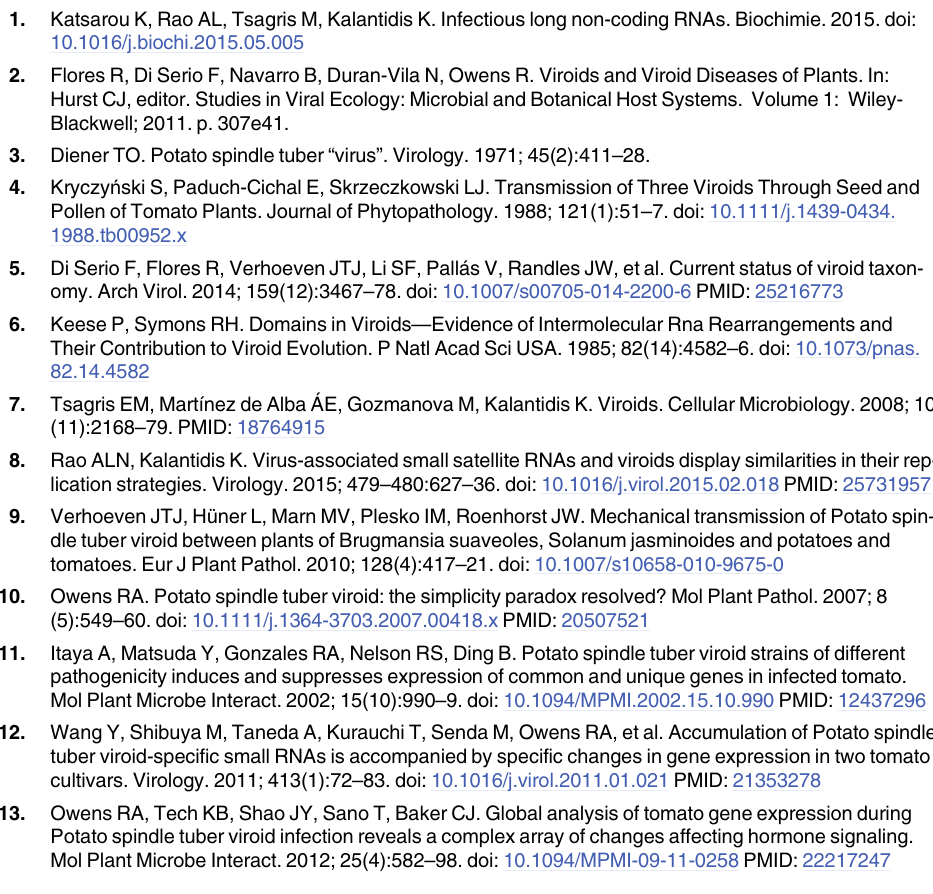
S5 Table. Primers used in this study. List of primers which were used in this study with the corresponding transcript number, sequence and UPL probe